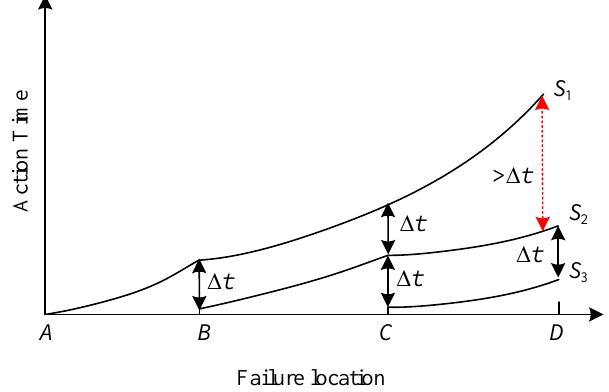
Figure 9. Action time curve of IA-ITOC protection.